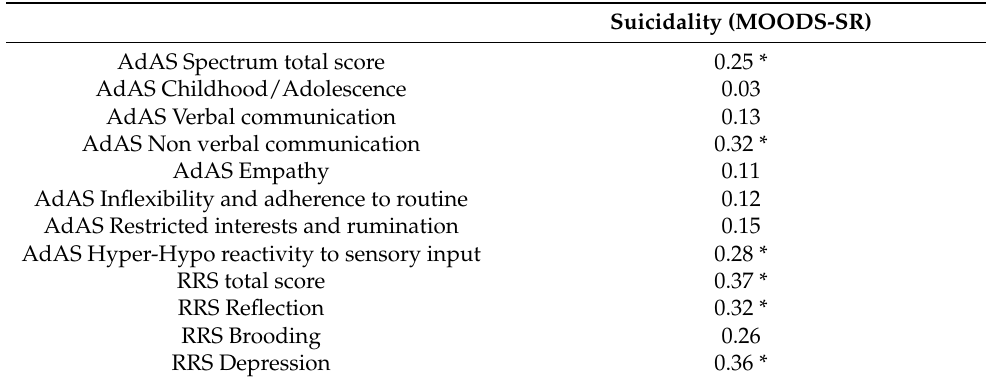
Table 3. Pearson’s c orrelations coefficients ( r ) among Suicidality score and Adas Spectrum/RRS scores in the BPD group.